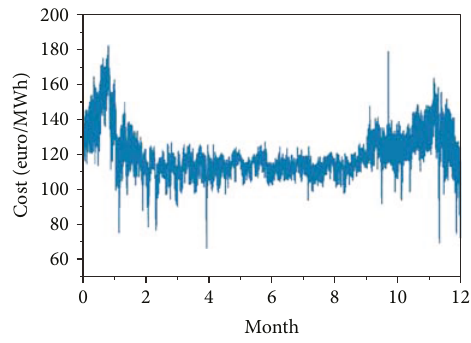
Figure 3: Actual hourly real-time electricity price in